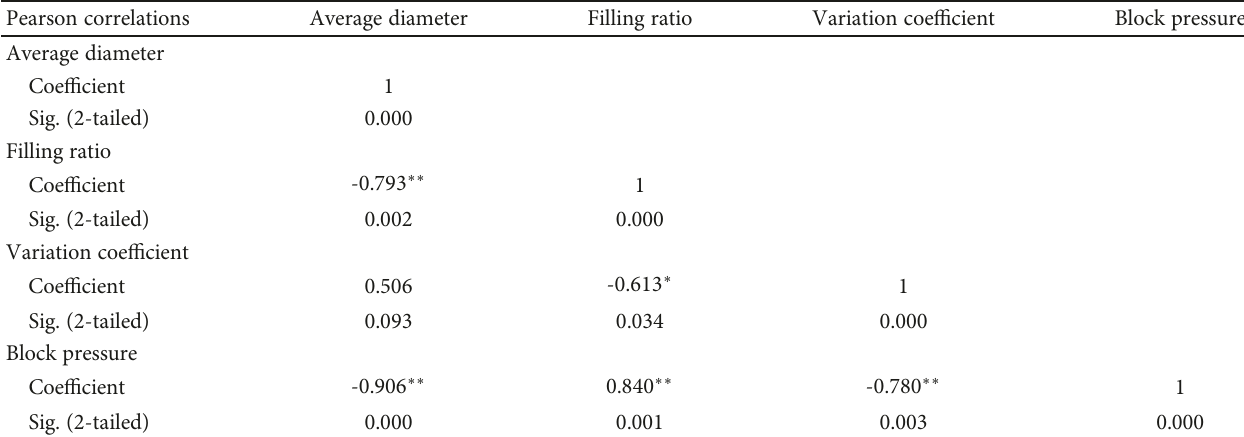
Table 3: Pearson correlation matrix.